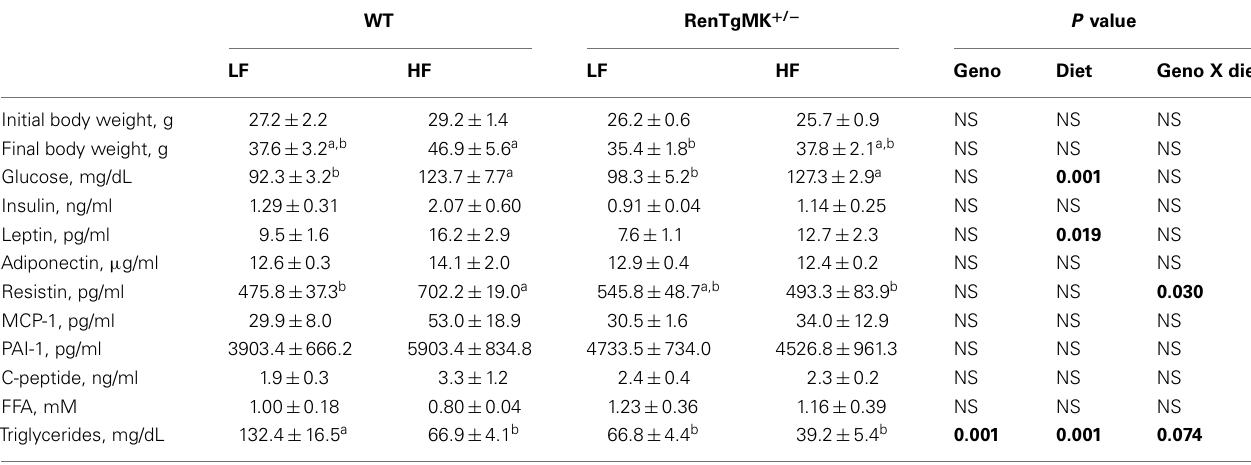
Table 3 | Effects of high-fat diet on body weight and metabolic characteristics in male wild-type and RenTgMK + / − mice.